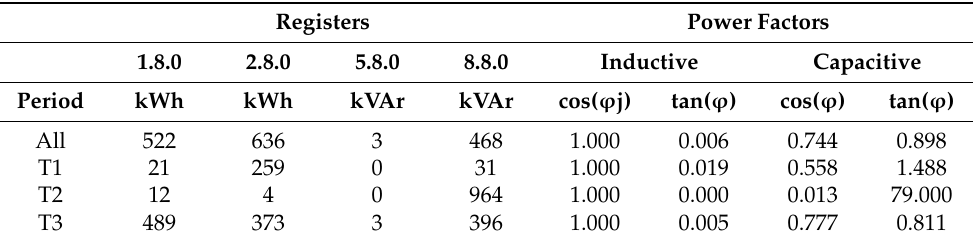
Table 12. Structure of energy imported and exported and calculated average powers factors in 3 months summer period.